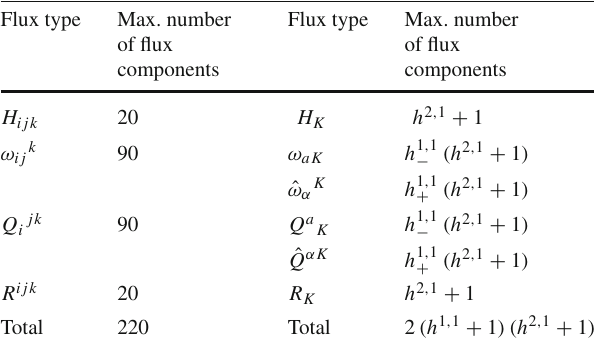
Table 2 Maximum number of flux components inthe two formulations